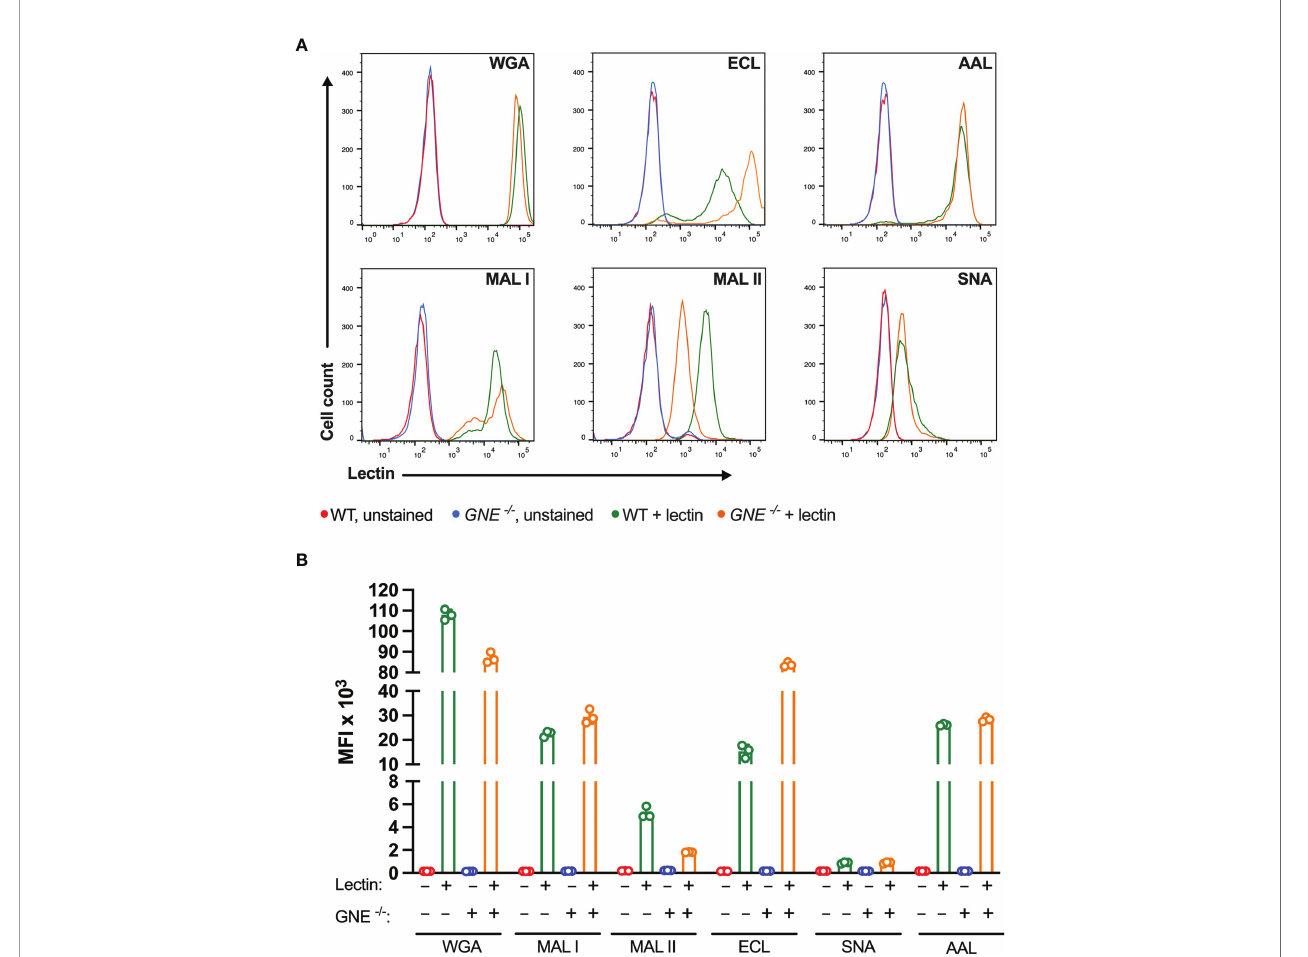
FIGURE 1 | Binding of plant lectins to MC-38 cells. (A, B) Binding ability of lectins used in the study to MC-38 cells with unaffected membrane sialylation level (MC- 38 WT) and desialylated (MC-38 GNE -/- ) measured by fl ow cytometry. Unstained MC-38 WT (red lines), stained MC-38 WT (green lines), unstained MC-38 GNE -/- (blue lines), stained MC-38 GNE -/- (orange lines). Each lectin was used at 10 µg/ml. Data are presented as mean and standard deviation of three